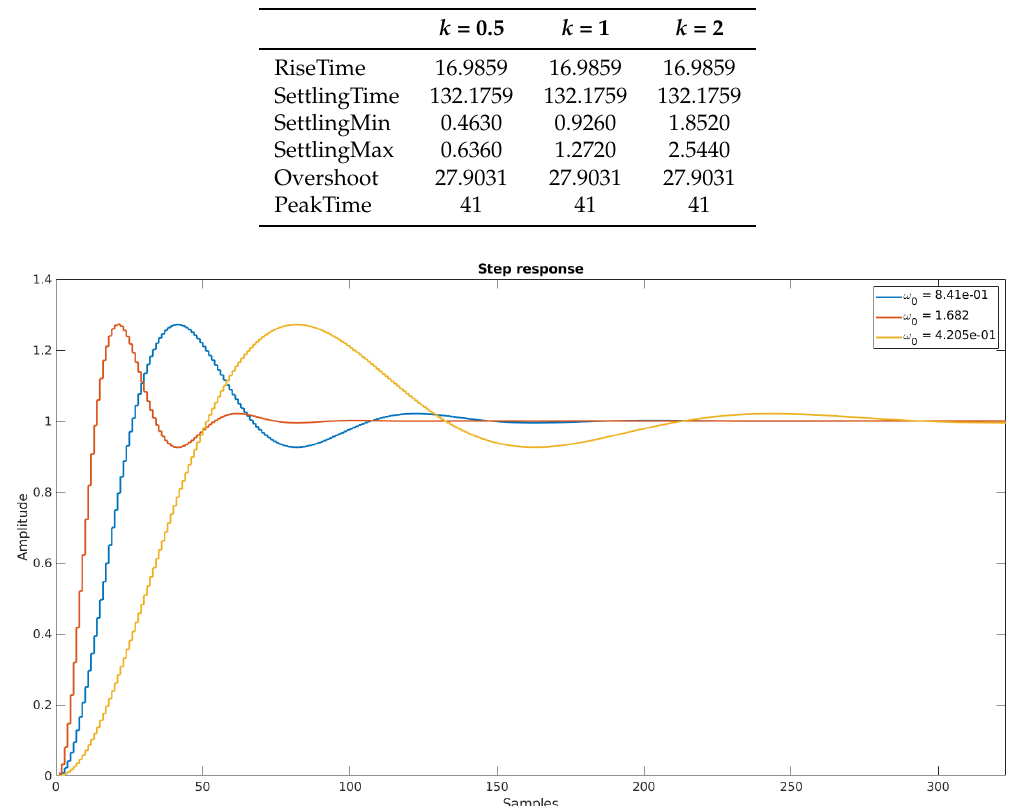
Figure 3. Comparison of the digital oscillatory system with ω 0 = 8.41 · 10 − 1 ; ζ = 3.83 · 10 − 1 ; k = 0.5 (orange), 1 (blue), and 2 (red); and t s = 1/10 s. Table 1. Step response characteristics for k = 0.5, 1, and 2. RiseTime—time it takes for the response to rise from 10% to 90% of the steady-state response; SettlingTime—time it takes for the error to fall to within 2% of steady-state response; SettlingMin—minimum value once the response has risen; SettlingMax—maximum value once the response has risen; Overshoot—percentage overshoot; and PeakTime—time at which the peak value occurs.